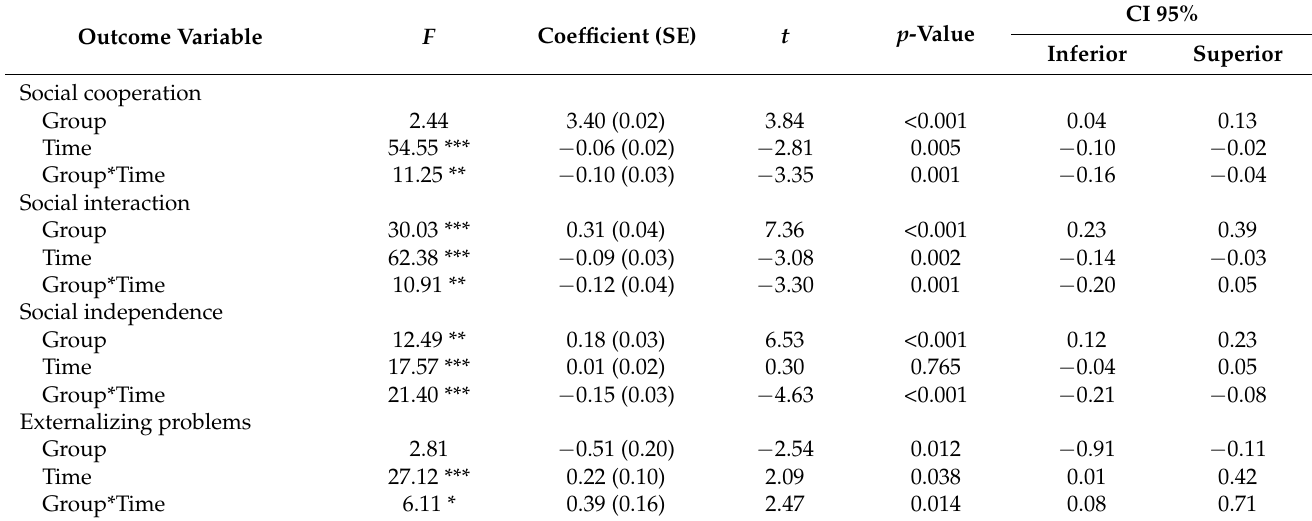
Table 6. Results of generalized linear mixed models estimating change in outcomes social skills and externalizing problems. Outcome